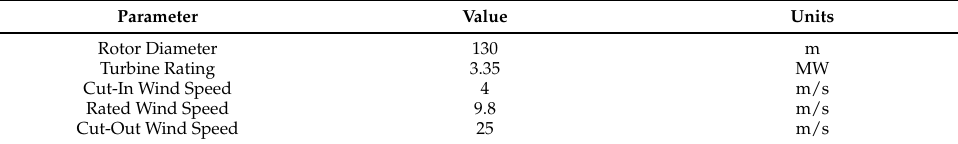
Table 3. Attributes for NREL’s 3.35-MW onshore reference turbine [56].